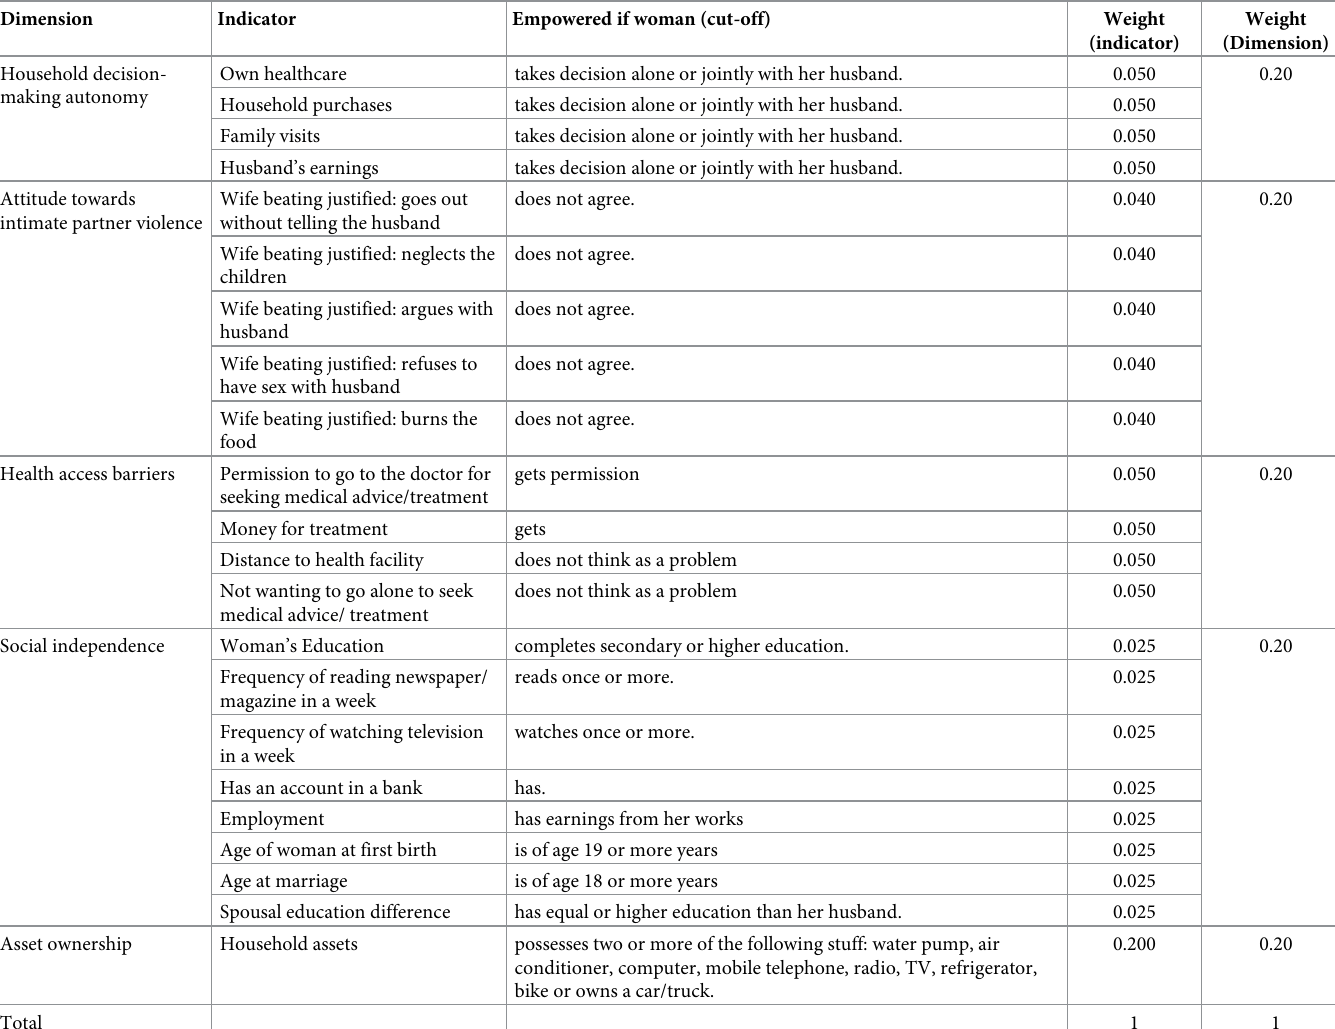
Table 1. Dimensions, indicators, cut-offs and weights of women’s multidimensional empowerment index (MEI), BDHS, 2017–18. Dimension Indicator Household decision- making